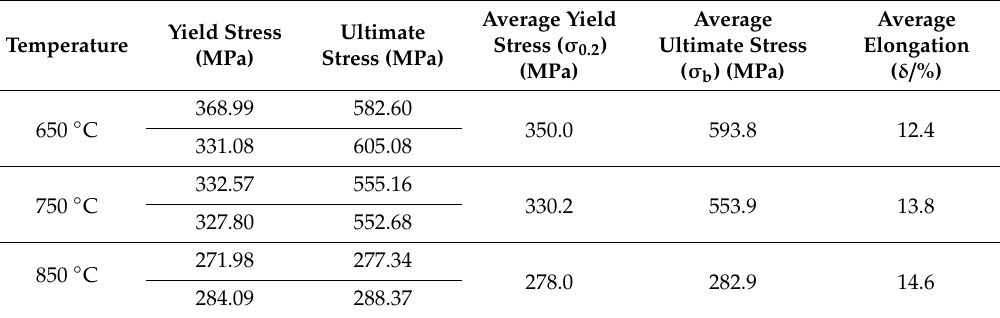
Figure 4. Tensile test results for di ff erent temperatures: 650 ◦ C / 750 ◦ C / 850 ◦ C. ( a ) stress-strain curve of the high-temperature tensile experiment; ( b ) the change trend of high-temperature tensile mechanical properties parameters ( σ 0.2 , σ b and δ ) with the test temperature. Table 2. Mechanical characteristics of the alloys determined at di ff erent testing